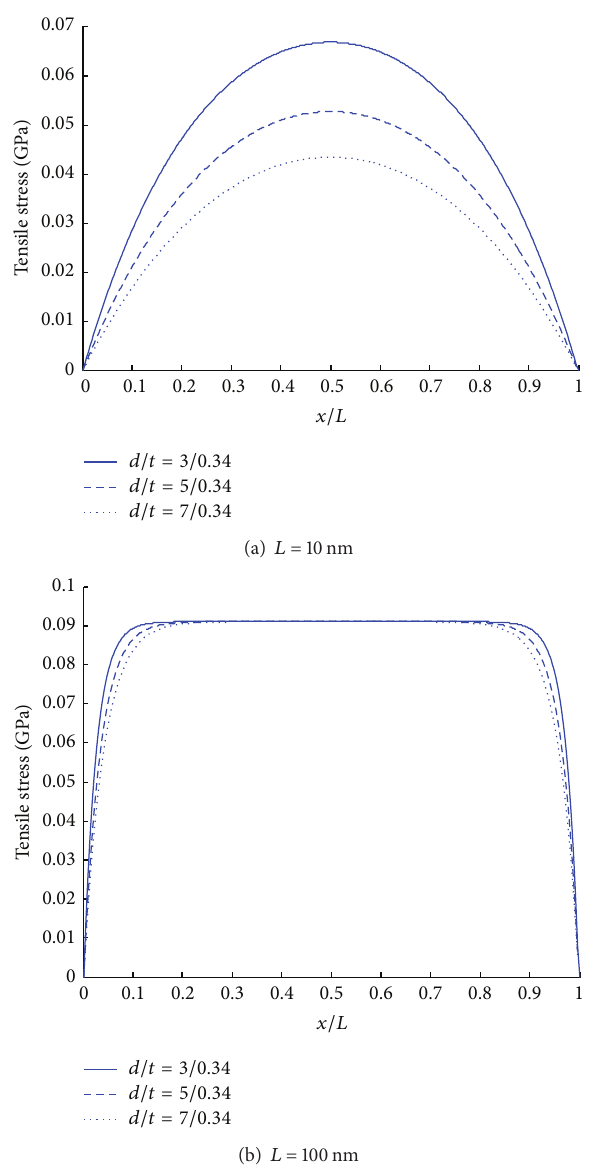
Figure 10: Effects of tube diameter 𝑑 on the tensile stress, (a) 𝐿 = 10nm and (b) 𝐿 =